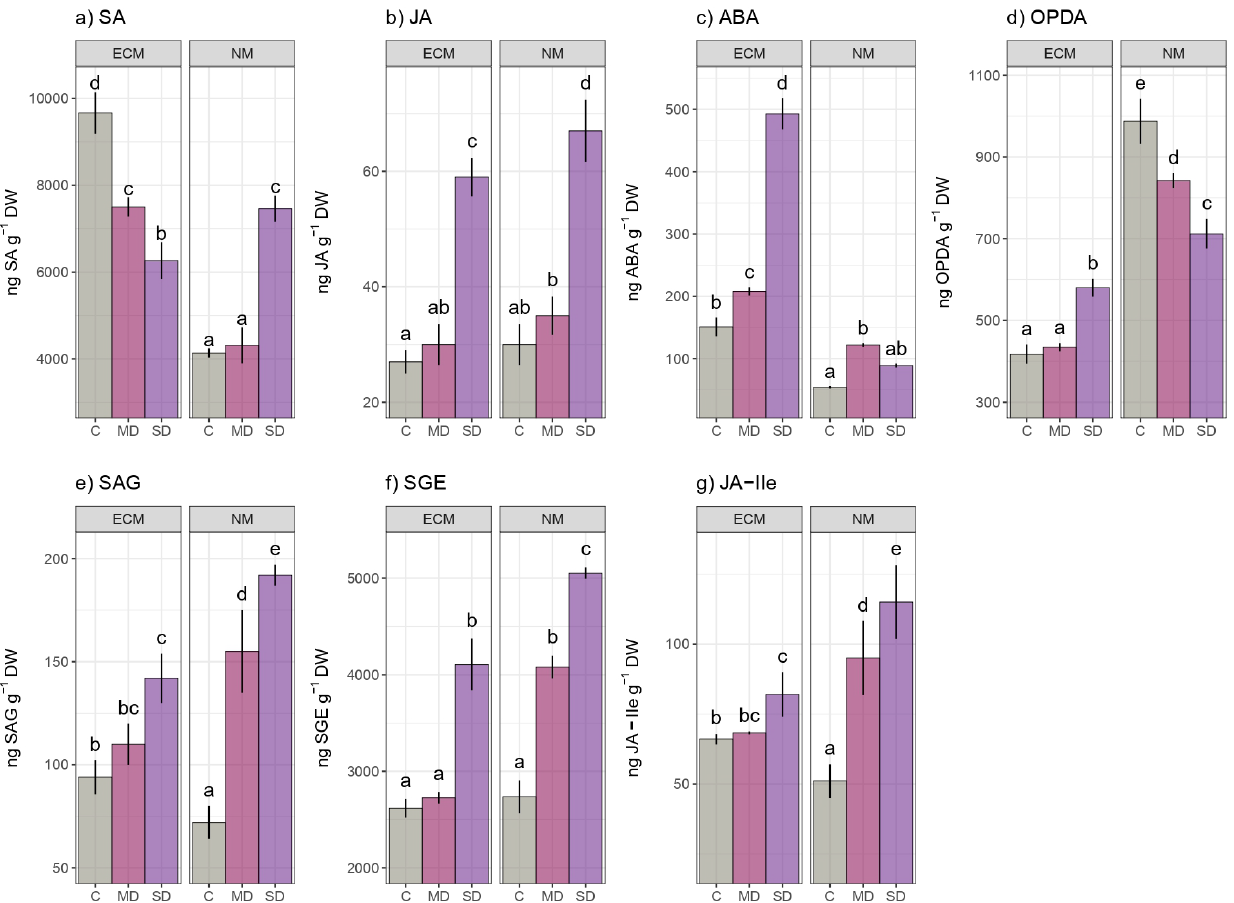
Figure 4. The effects of mycorrhization and/or drought on plant hormones and their conjugates: ( a ) salicylic acid (SA); ( b ) jasmonic acid (JA); ( c ) abscisic acid (ABA) ( d ) 12-oxo-phytodienoic acid (OPDA) ( e ) salicylic acid glucoside (SAG) ( f ) salicylic acid glucose ester (SGE) ( g ) jasmonate-isoleucine (JA-Ile) in leaves of Q. robur . Treatments: C-control regularly watered oak seedlings, MD-oak seedlings exposed to the mild drought that corresponds with 60% of soil water field capacity, SD-oak seedlings exposed to the severe drought that corresponds with 30% of soil water field capacity ECM-oak seedlings inoculated with ectomycorrhizal inoculum, and NM-oak seedlings not inoculated with ectomycorrhizal inoculum. Different small letters indicate significant differences across the different treatments; Tukey’s honestly significant difference (HSD) post hoc test ( p ≤ 0.05). Data represent the mean ± standard deviation (SD).